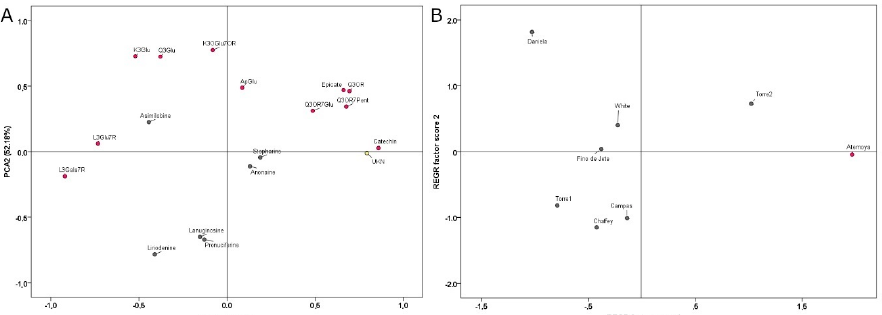
Figure 2. Scatter plot of the principal components (PC1 and PC2) factor scores calculated on the PCA of phenolic and alkaloid compounds of the seven extracts of Cherimoya and Atemoya leaves. PCA was performed using the data matrix in Table 2 obtained with HPLC-DAD-ESI-MS/MS analysis. Panel A represent the partitioning of the different compounds based on PC1 and PC2 factor scores. Panel B represent the partitioning of the different genotypes and cultivars according to their chemical composition.